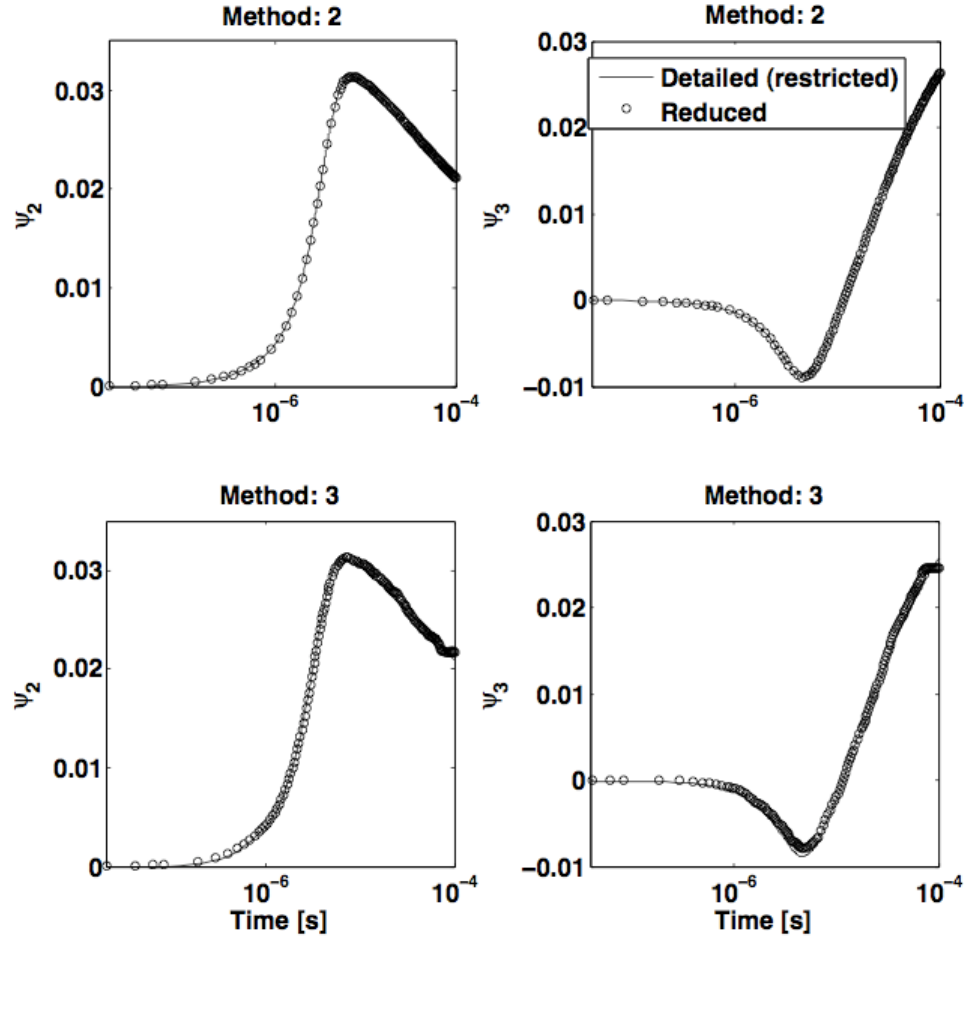
Figure 13. Time evolution of the two diffusion map variables along the solution trajectory of Figure 11 as obtained by Method 2 ( top ) and by Method 3 ( bottom ) (see Table 1). The initial condition in the Diffusion Maps’ space [0 , 0] is first lifted into (cid:60) 9 and then relaxed towards the equilibrium point by the detailed kinetics Equation (8) using the readily available Matlab solver, ode45 . The latter time series is afterwards restricted to the Diffusion Maps’ space and reported with a continuous line. Symbols denote the corresponding solution directly obtained in the reduced space by solving system Equation (13) by the same Matlab solver, ode45